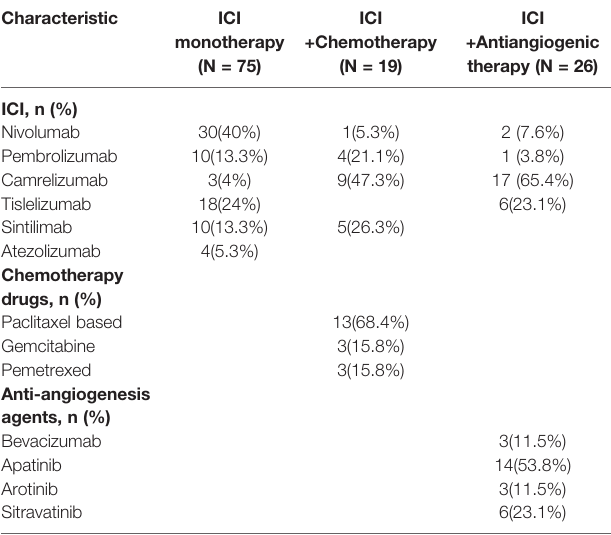
TABLE 2 | The summary of ICI, chemotherapy and anti-angiogenesis agents.